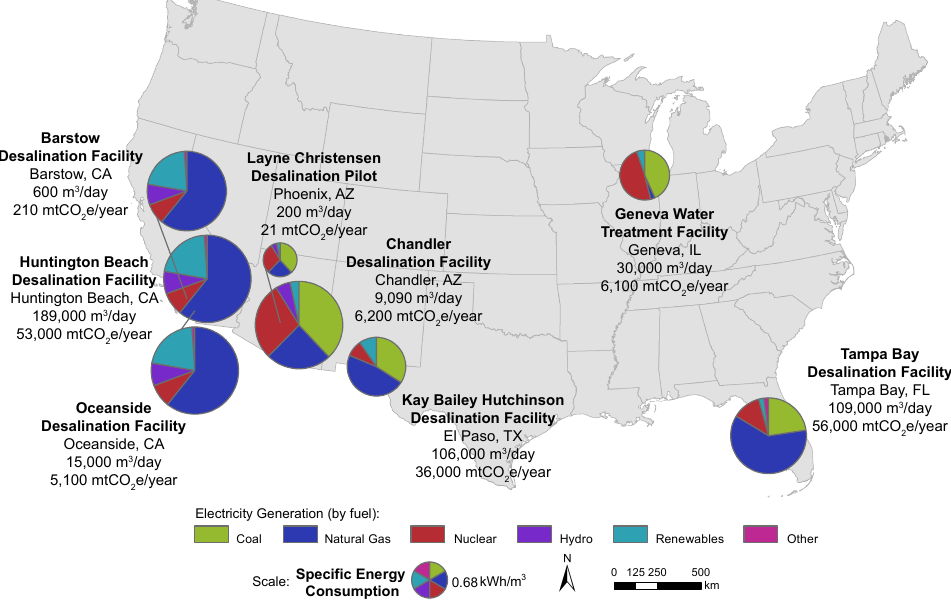
Figure 3. Greenhouse gas emissions associated with electricity consumption for desalination vary with location in selected U.S. desalination facilities. Larger circles correspond to higher specific energy